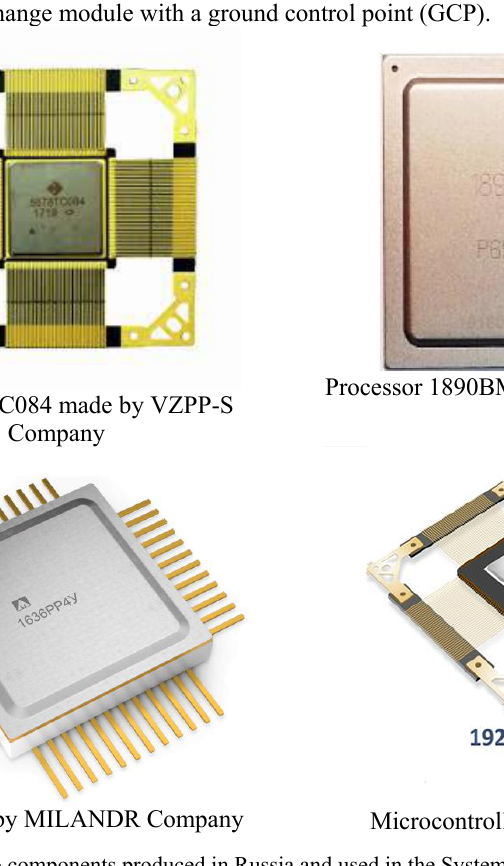
Fig. 4. Some radio components produced in Russia and used in the